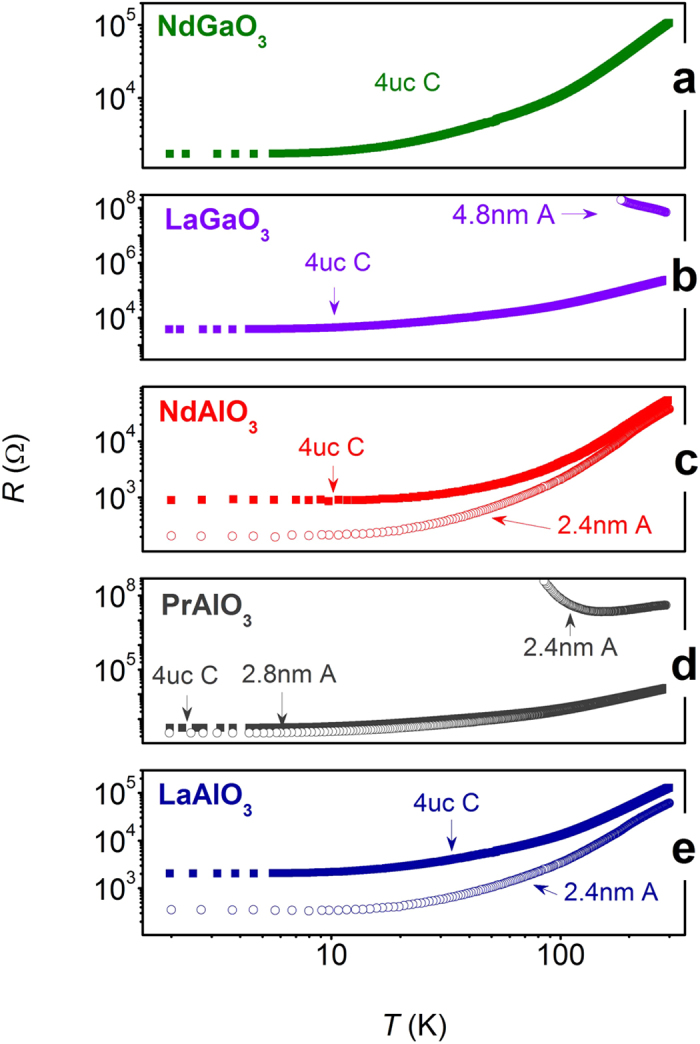
Temperature dependent sheet resistance for crystalline and amorphous ABO3/STO with different thicknesses of ABO3- (a) NdGaO3, (b) LaGaO3, (c) NdAlO3, (d) PrAlO3 and (e) LaAlO3. “4 uc C” means 4 uc (~1.6 nm) of polar ABO3 layer in crystalline form, and “2.4 nm A” refers to 2.4 nm of polar layer in amorphous form.